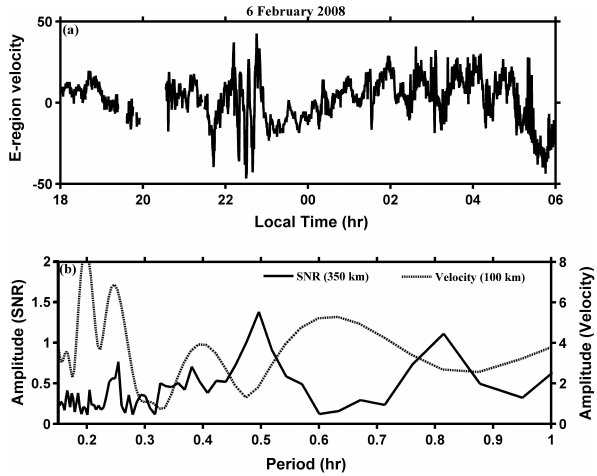
Fig. 2. (a) Line-of-sight Doppler velocities of the E-region echoes observed above 105km. (b) Amplitude of different periods in the occurrence of plumes (red line) and in the E-region velocities (ma- genta